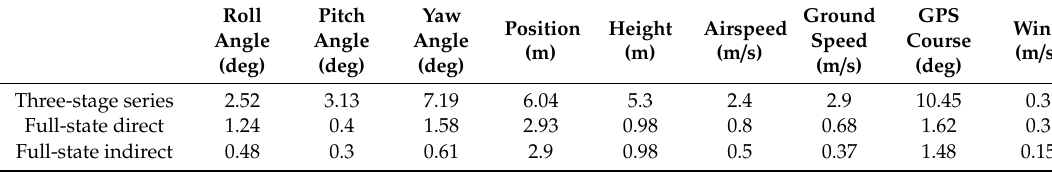
Figure 11. Comparison of true and estimated state. Table 2. Comparison of the estimate accuracy of three algorithms.